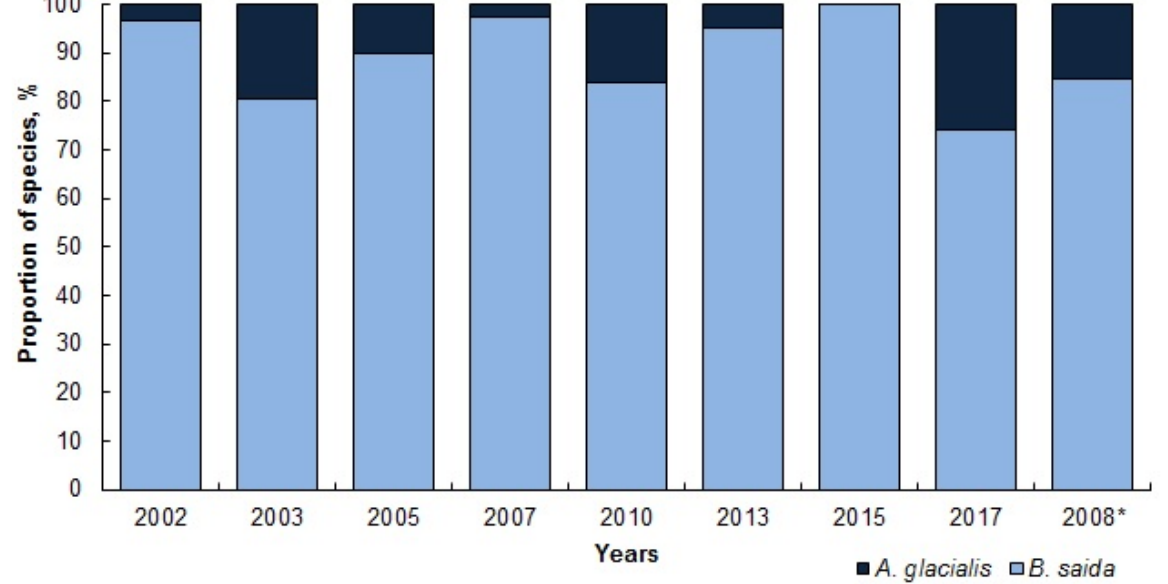
Figure 2. The overall proportional biomass in catches revealed by the cryopelagic fishes, ice cod Arctocgadus glacialis and polar cod Boreogadus saida in Northeast Greenland waters. * Note, the year 2008 represents only one station near Jan Mayen Island (Figure 3), and in 2015, only the shelf was sampled. The number of fjord and shelf stations is shown in Table 1.